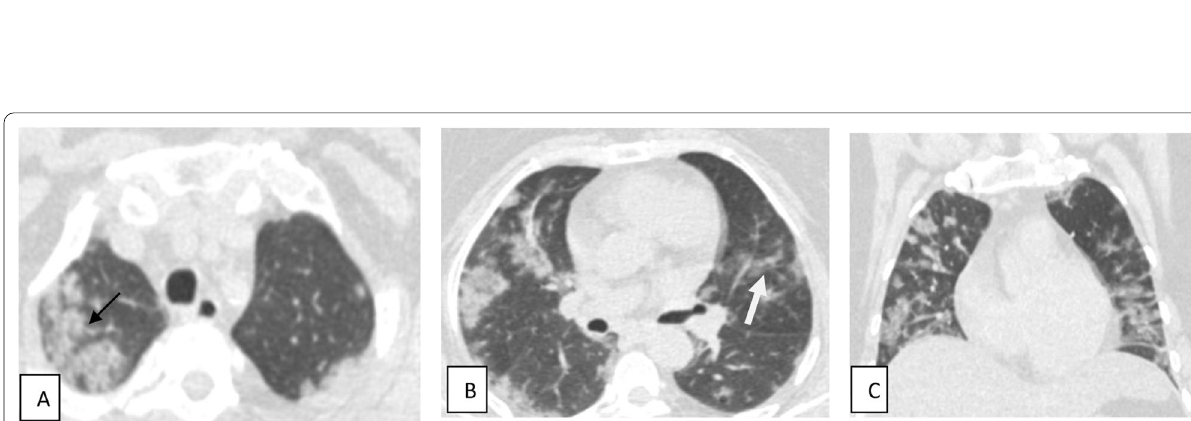
Fig. 3 Female patient 46 years old presented by cough, dyspnea and fever. Axial ( A , B ) and coronal ( C ) CT images show bilateral multifocal ground‑glass opacities (white arrow); areas of consolidation and areas of interstitial thickening giving crazy‑paving appearance (black arrow) are seen involving both lung fields with peripheral/subpleural predominance (moderate to severe